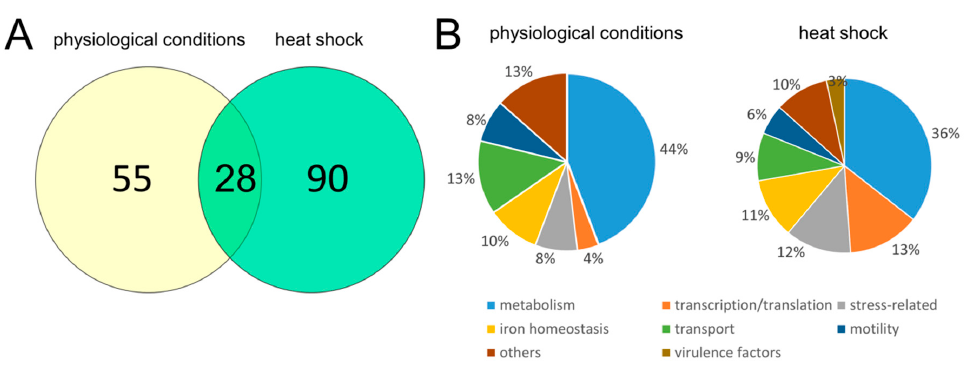
Figure 8. Number ( A ) and percentage ( B ) of proteins whose expression level was changed in the Δ lon mutant under physiological and heat shock conditions. Data are categorized into 8 groups depending on the protein function. Physiological and heat shock conditions refer to temperatures 30 °C and 40 °C, respectively. Table 1. Summary of proteins whose level depends on Lon protease. Protein